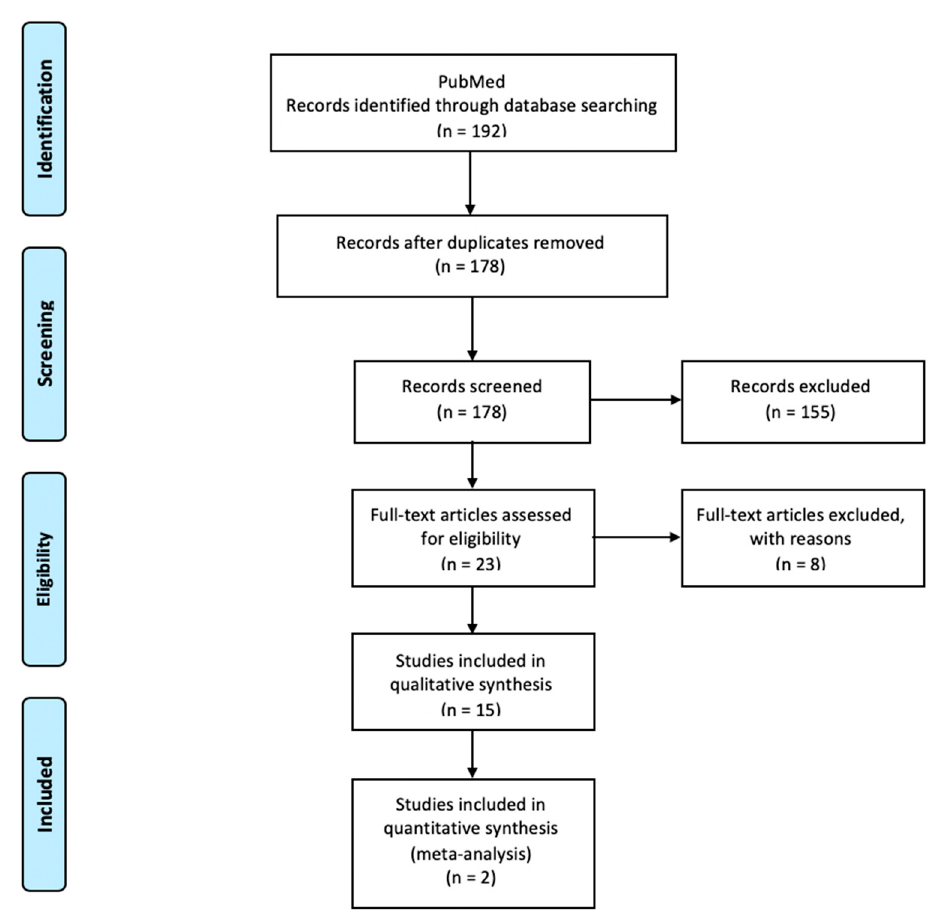
Figure 1. Preferred Reporting Items for Systematic Reviews and Meta-Analyses (PRISMA) flow diagram of selection process.